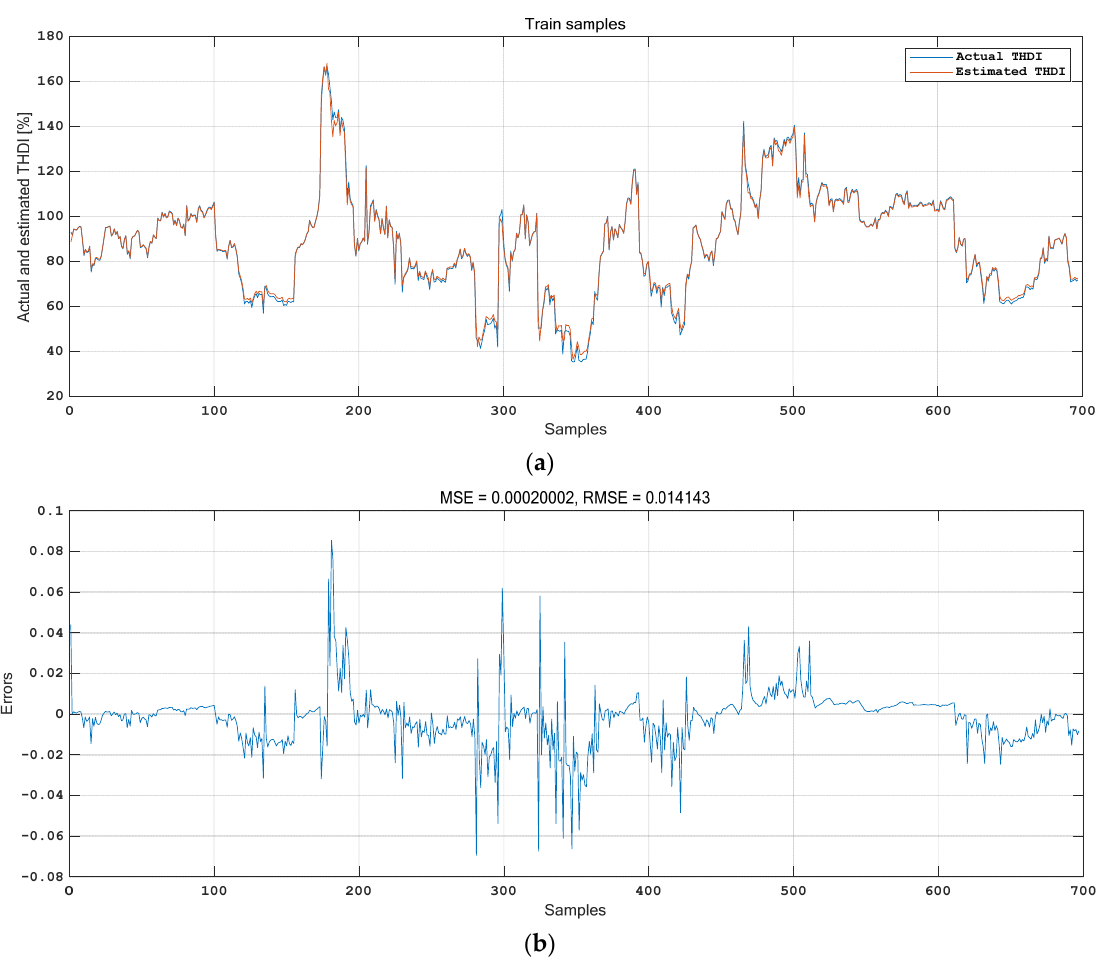
Figure 10. THDI variation ( a ) and errors variation ( b ) for the training data for the following parameters: nMax = 16, maxL = 6, α = 0.5, m = 5, and pTrain = 70%. Error Mean = -0.0019105, Error StD = 0.014023